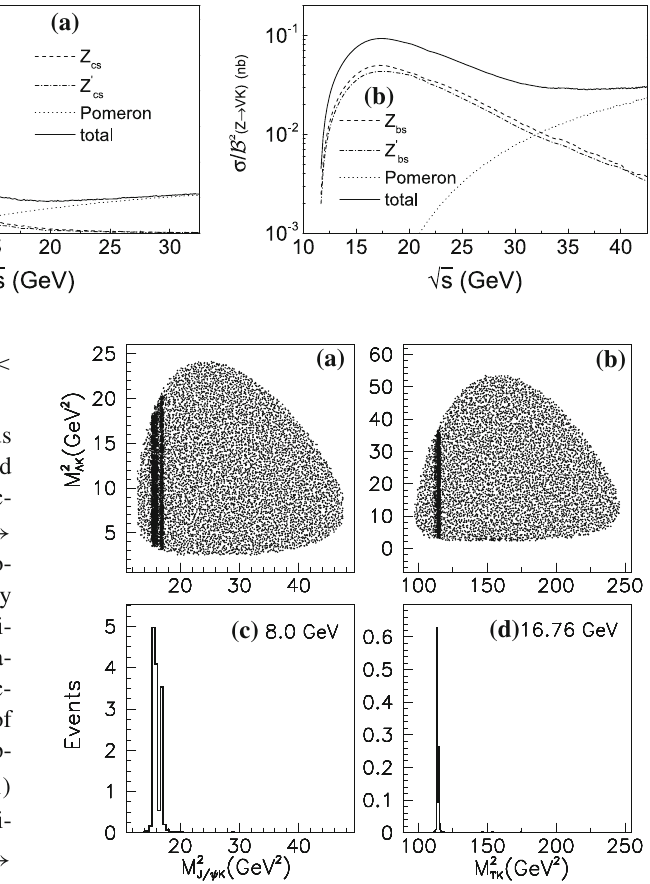
Fig. 7 The Dalitz plots (top) and invariant mass spectra (bottom) of the a , c γ p → (cid:3) J /ψ K at s = 16 .